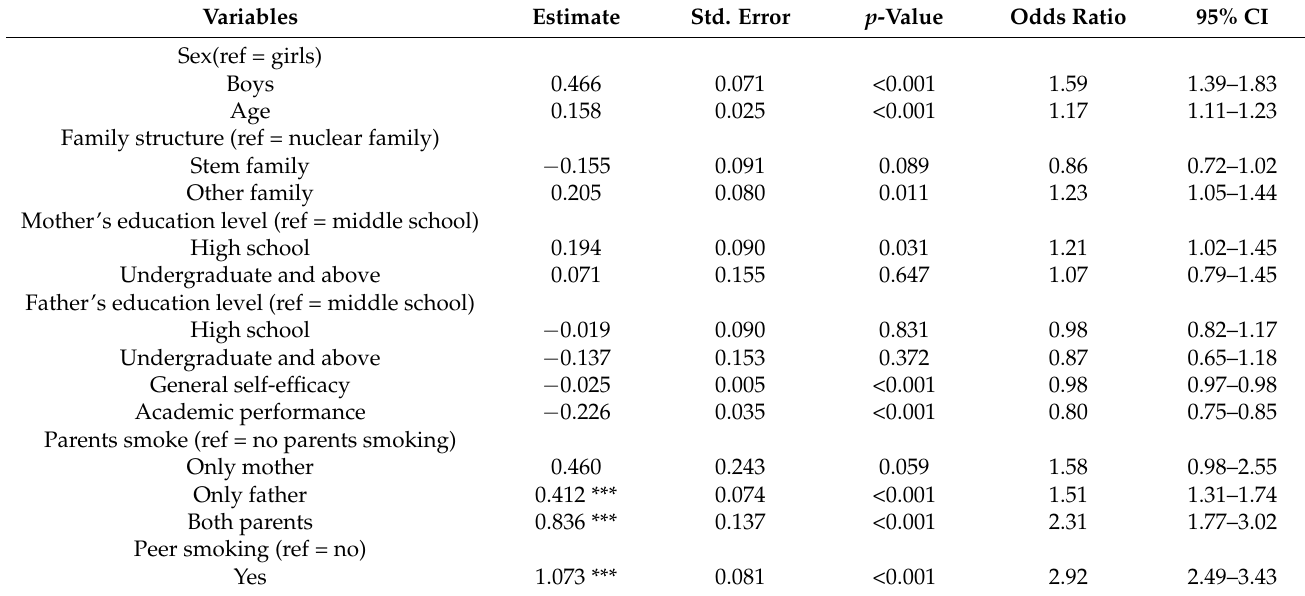
Table 2. Multivariate logistic model for factors associated with intention to smoke among non- smoking students.